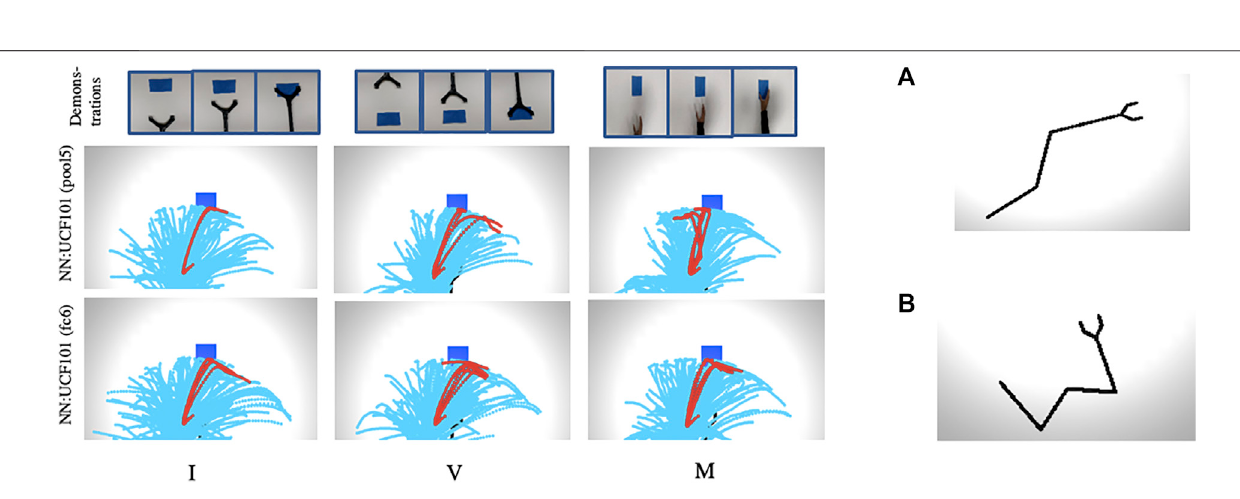
Frontiers in Robotics and AI |